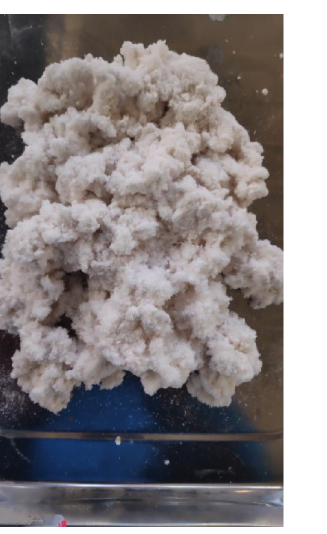
Figure 5: The lignocellulose used in the test. Table 3: The characteristic parameters of lignocellulose.